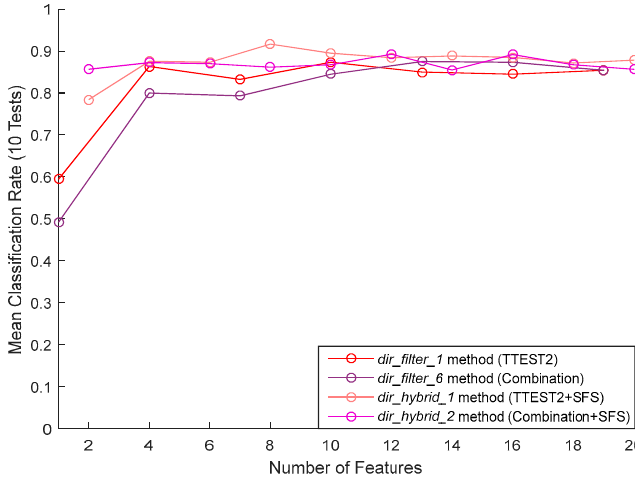
Figure 18. Comparison between the performances of the filter and the hybrid selection methods.